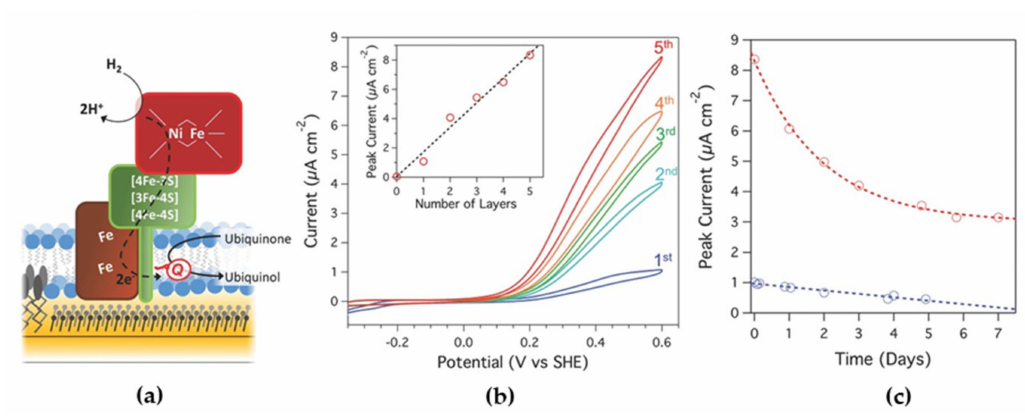
Figure 4. ( a ) Scheme of immobilized MBH activity on a biomimetic membrane-modified electrode. Ubiquinone is reduced by the enzyme to ubiquinol using electrons generated from hydrogen oxidation. The ubiquinone is reoxidized at the electrode. ( b ) Cyclic voltammograms (CVs) for 1–5 lipid bilayers containing MBH. Inset: Catalytic current (measured at 600 mV) as a function of the number of lipid bilayers. ( c ) Peak current (obtained at 600 mV) as a function of time (up to a week) for a